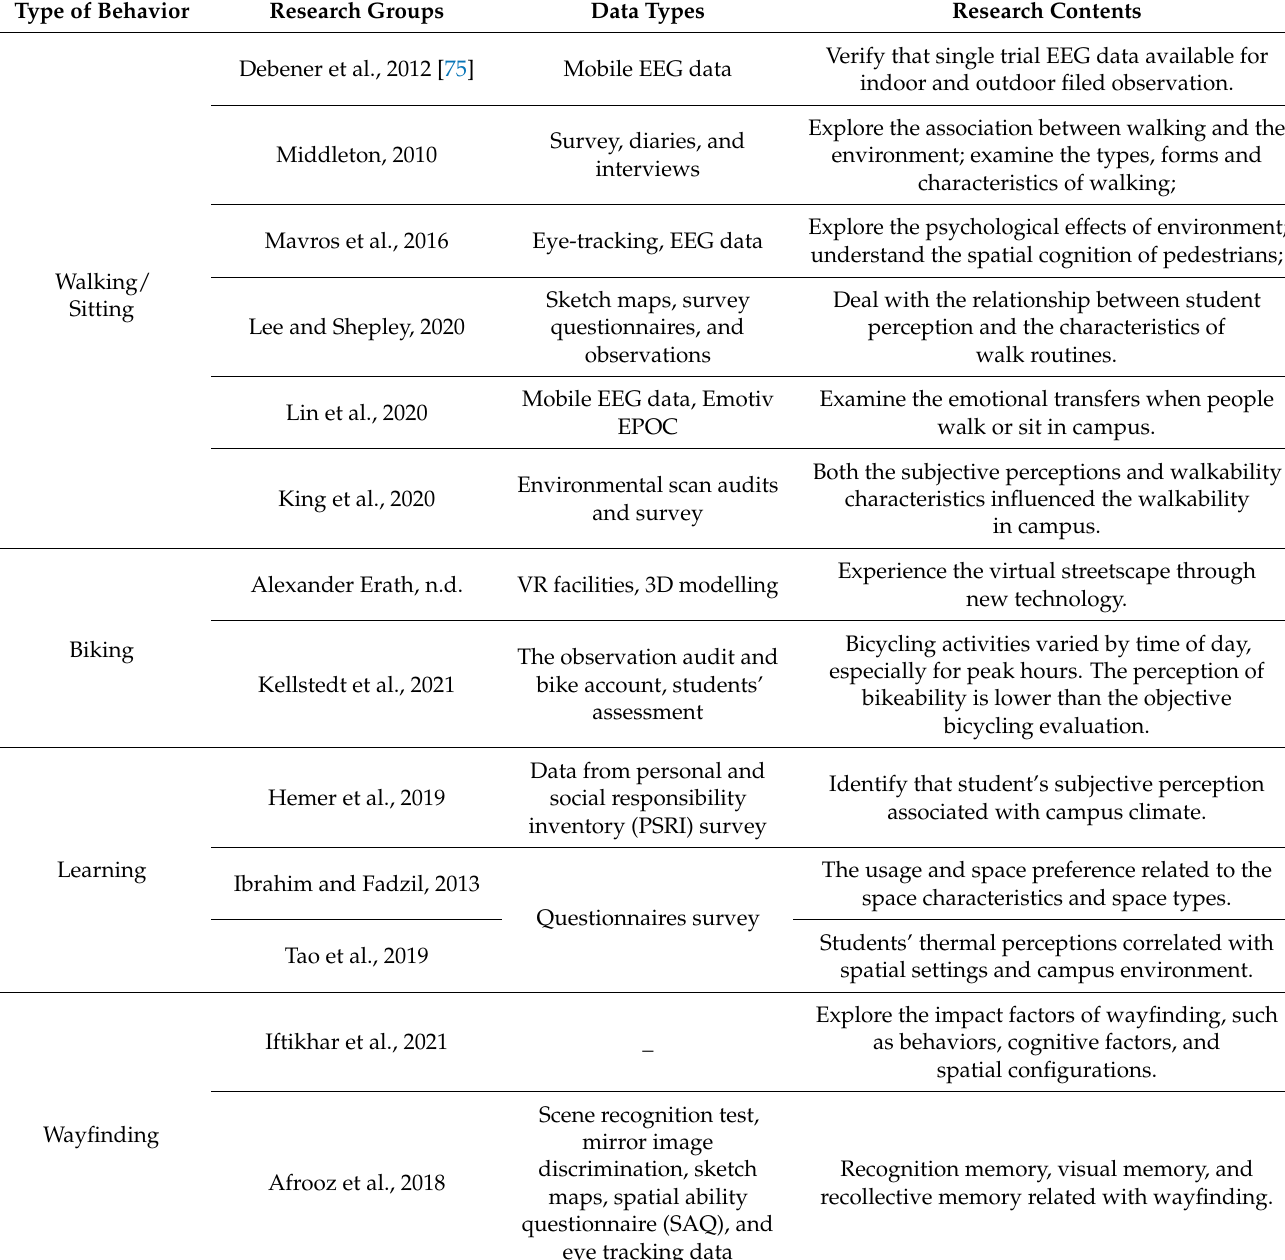
Table 4. Behavior perceptions of the public space on university